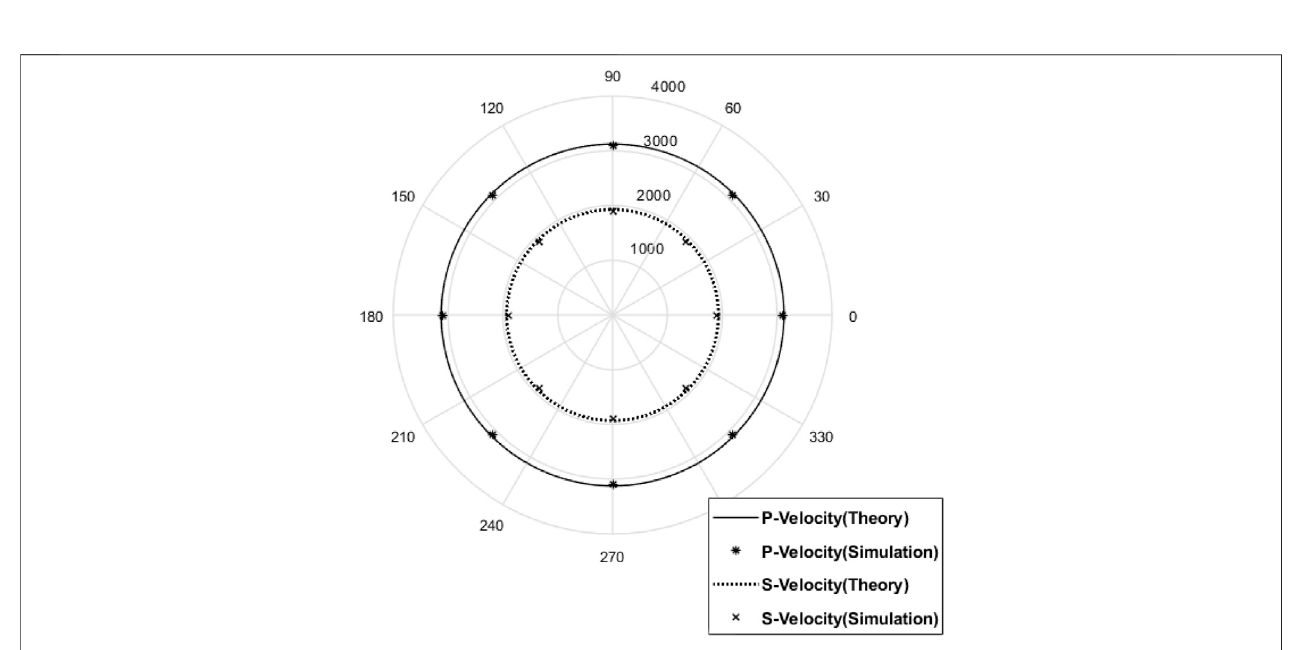
FIGURE 6 | Comparison of the theoretical and calculated wave velocities for both the P-wave and S-wave under the same pressure (10 MPa) but with different directions.